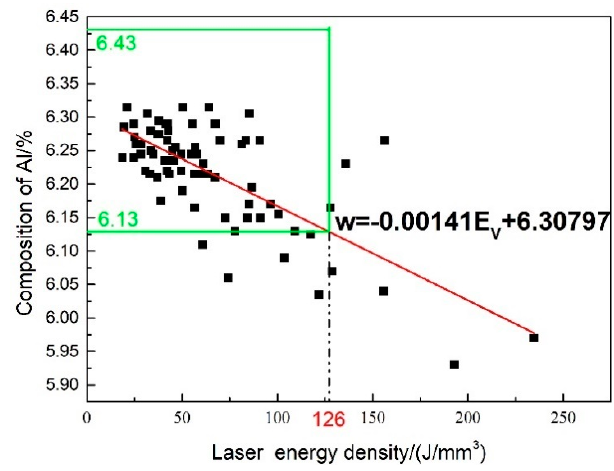
Figure 6. Relationship between body energy density and mass fraction of Al in formed components.